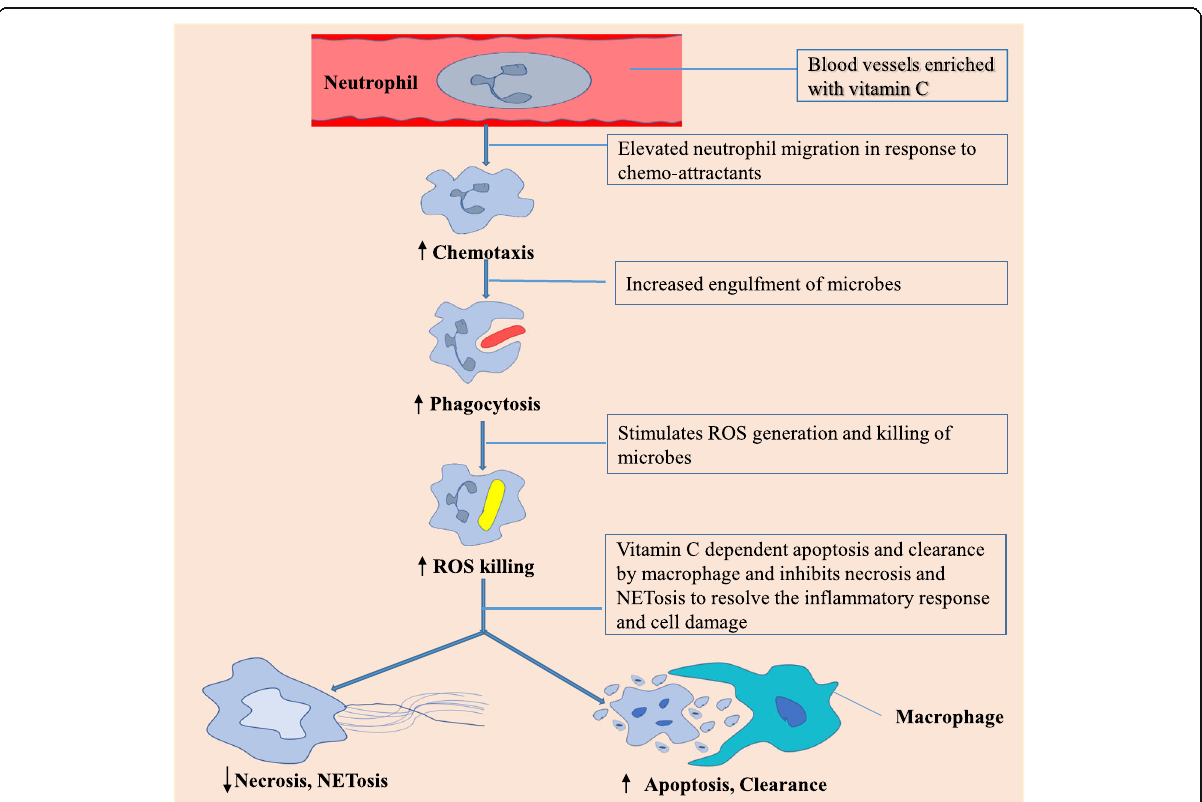
Fig. 2 The role of vitamin C in immune cell